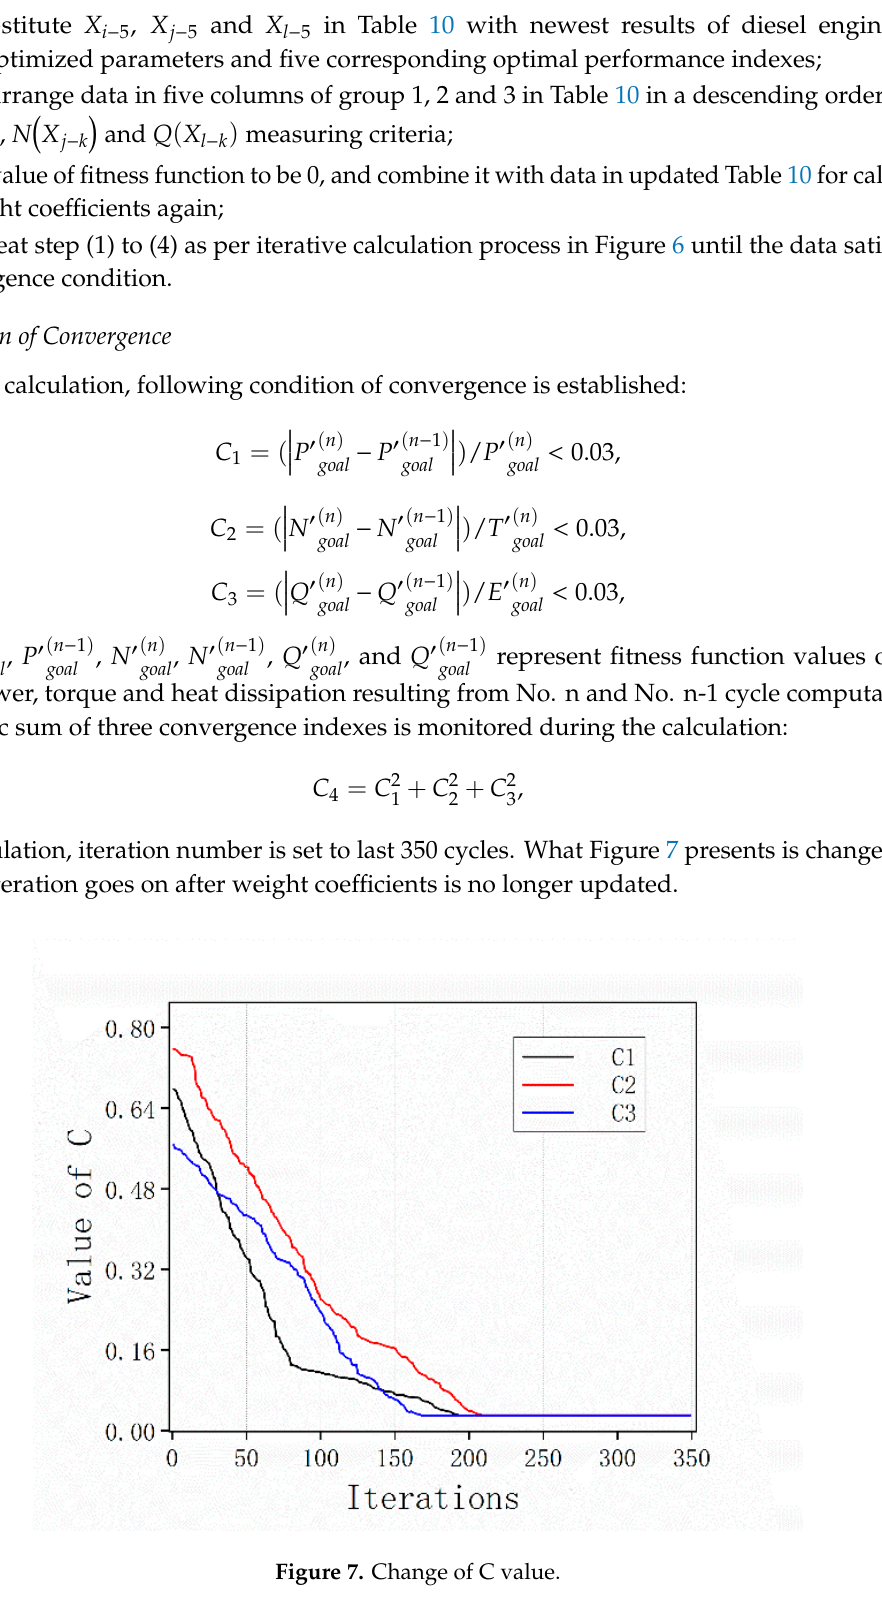
Table 12. Calculation results of diesel engine’s optimal state parameters.